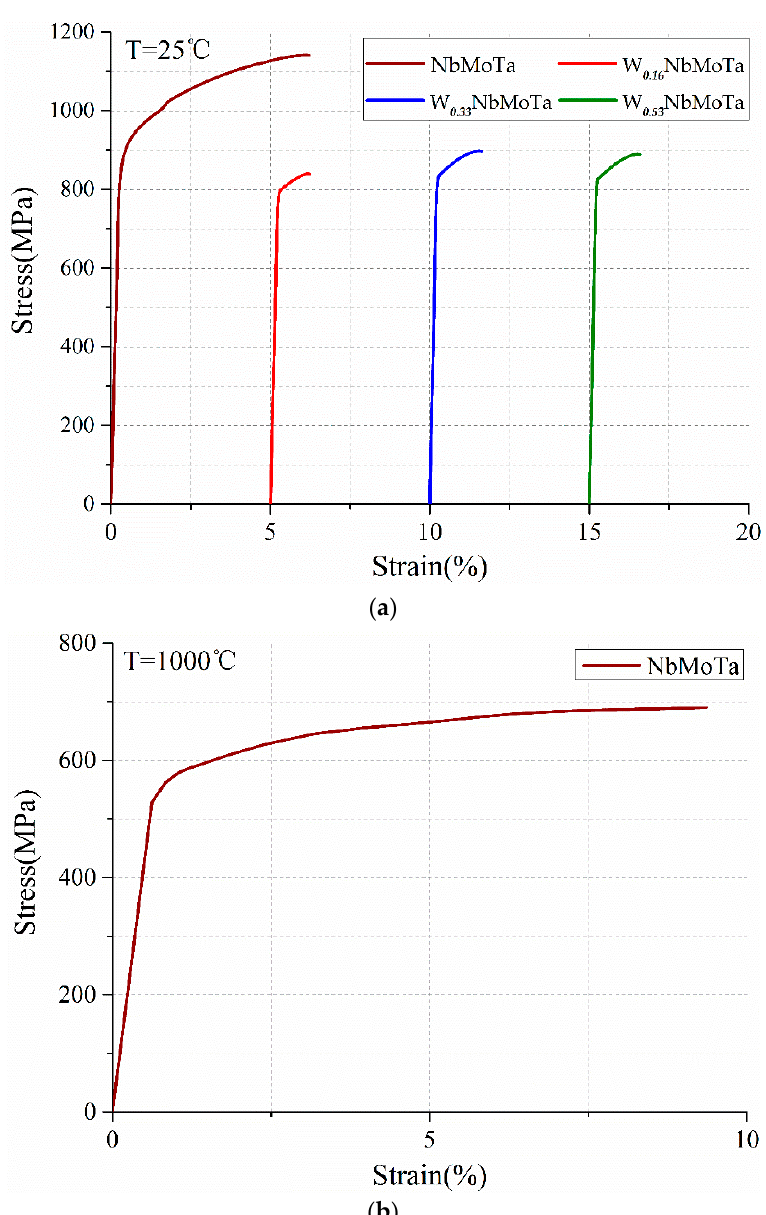
Figure 11. Compressive stress-strain curves of different temperature for the W x NbMoTa HEAs. ( a ) Room temperature, ( b ) high temperatures.